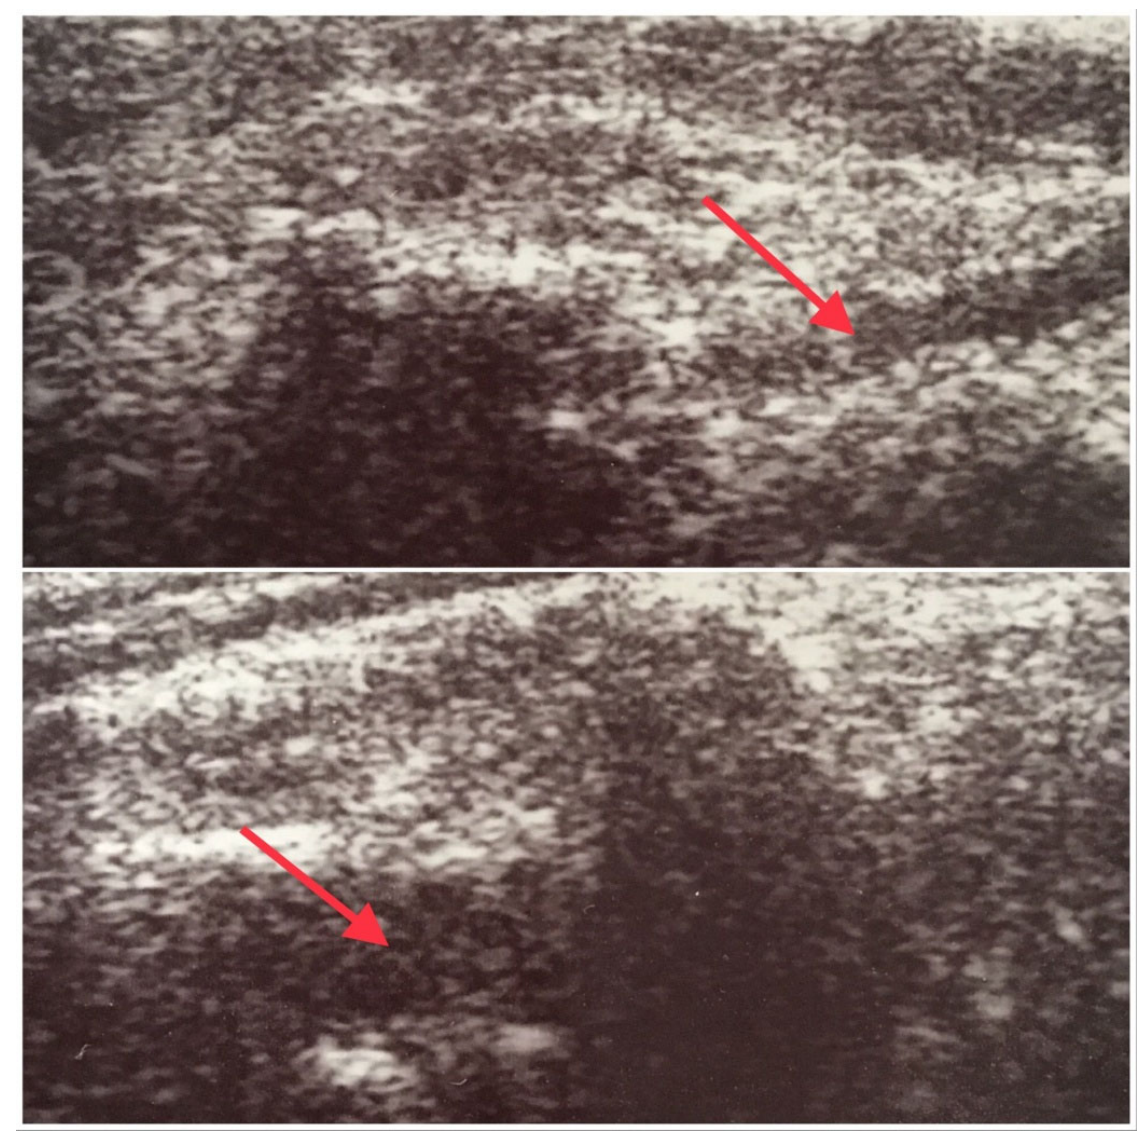
Figure 1. Comparison of the size of vertebral arteries: at the bottom ‐ typical vertebral artery with the diameter 4.3 mm, at the top ‐ hypoplastic vertebral artery with the diameter of 1.8 mm. Disturbances of the flow through the VA can lead to posterior inferior cerebellar artery (PICA) syndrome and basal artery syndrome. In the PICA syndrome, the most common symptoms and signs are vertigo, balance disturbances, vomiting. Ataxia may also occur. The severe cases may present as a full Wallenberg syndrome, characterized by Horner syndrome, paresis of the palate and posterior pharyngeal wall, trigeminal nerve dysfunction and hemiataxia ipsilaterally, as well as contralateral deficits of pain and temperature sensation on the trunk and limbs. Different clinical presentations may appear in the basilar artery syndrome, depending on the location of the occlusion in